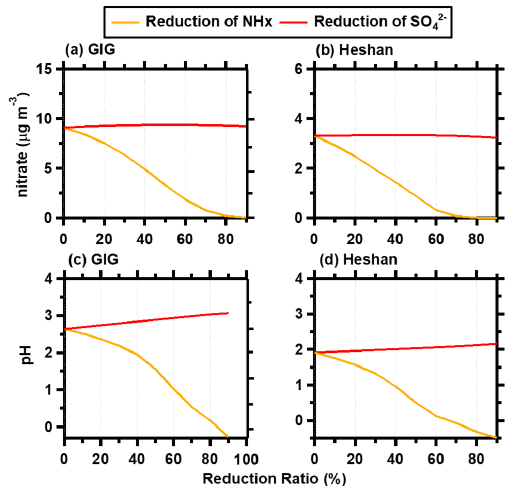
Figure 7. ISORROPIA-predicted average nitrate (a, b) and pH (c, d) as a function of changes in NH x (ammonium + NH 3 , orange line) and SO 2 − (red line) at the GIG and Heshan site during the 4 study period.